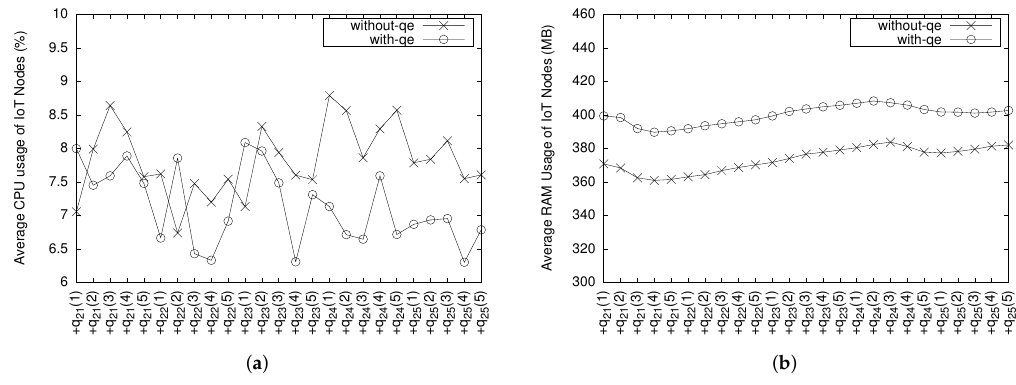
Figure 17. Average CPU and memory usage of all IoT nodes. ( a ) CPU usage; ( b ) Memory usage. Figure 18 indicates the average latency of each query after running all applications simultaneously.